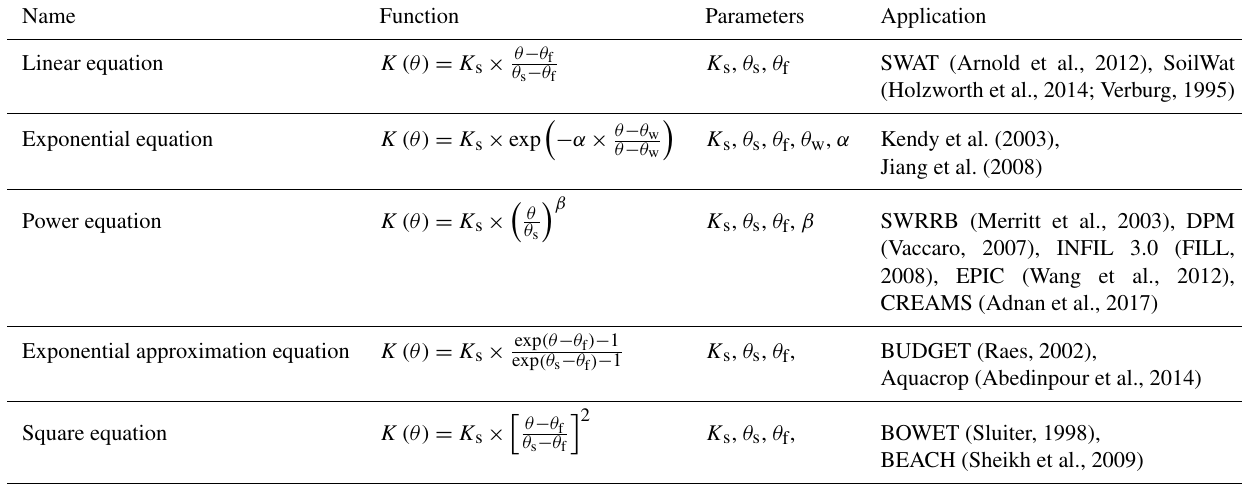
Table A1. Empirical drainage functions representing the relationship between the unsaturated hydraulic conductivity K(θ) and soil water content θ